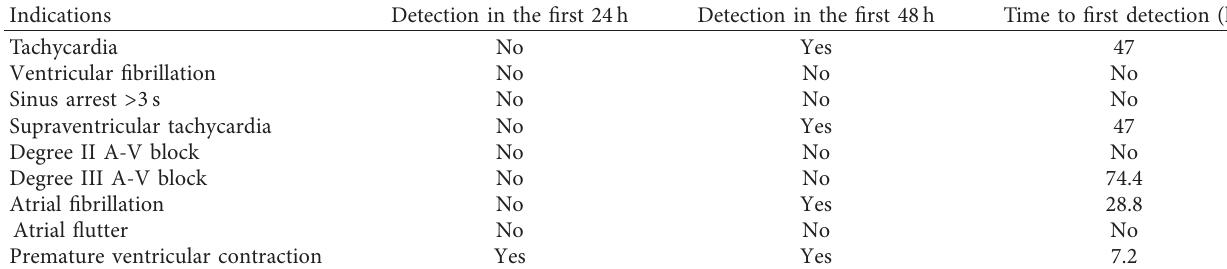
Table 4: Timing of arrhythmia